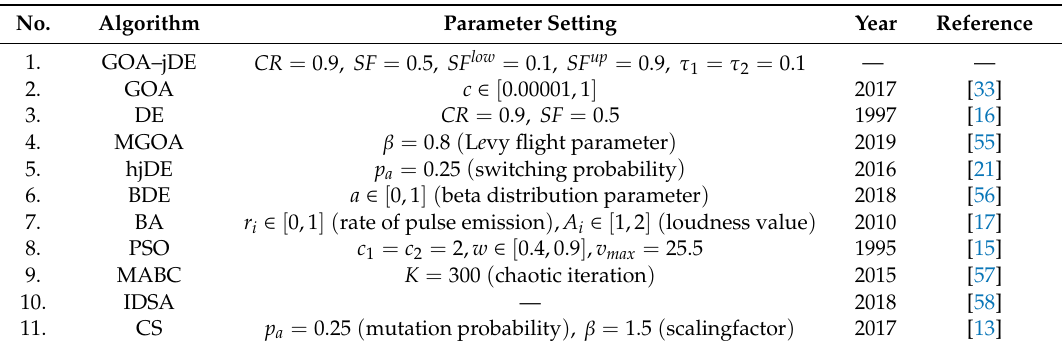
Table 3. Parameters of the